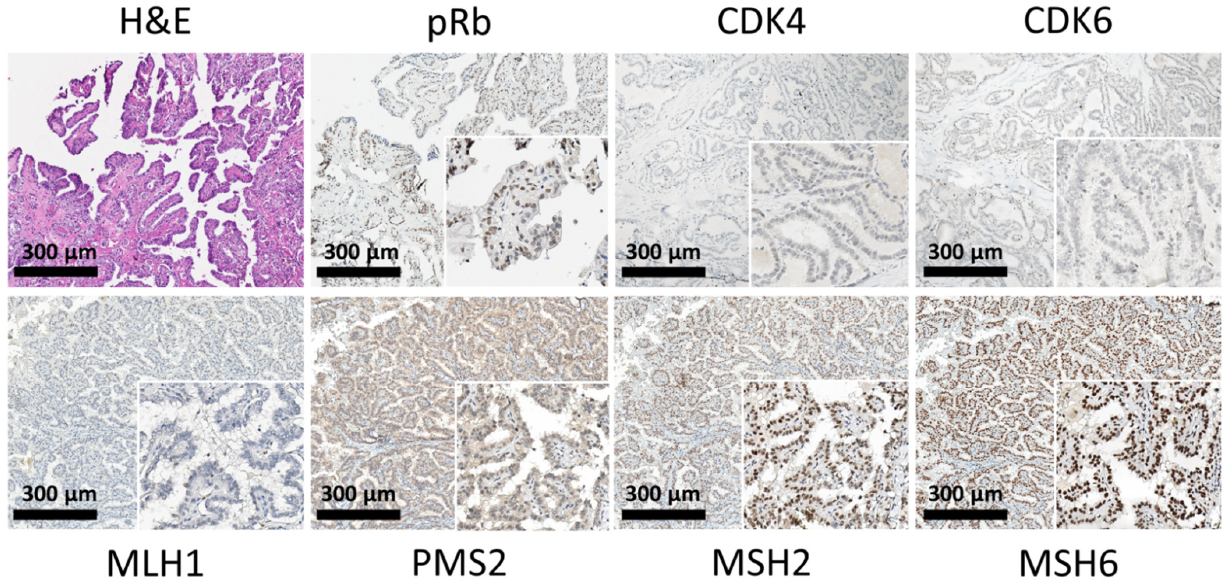
Figure 3. Representative immunohistochemical staining for the expression of pRb, CDK4, CDK6, and MMR proteins in the double primary cancer (DPC) group. Papillary carcinoma (left upper panel; H&E stain) showed high expression of pRb, while most cancer cells were negative for CDK4 and CDK6. Tumor tissue demonstrated deficient mismatch repair (dMMR) with loss of MLH1 and PMS2 expression.